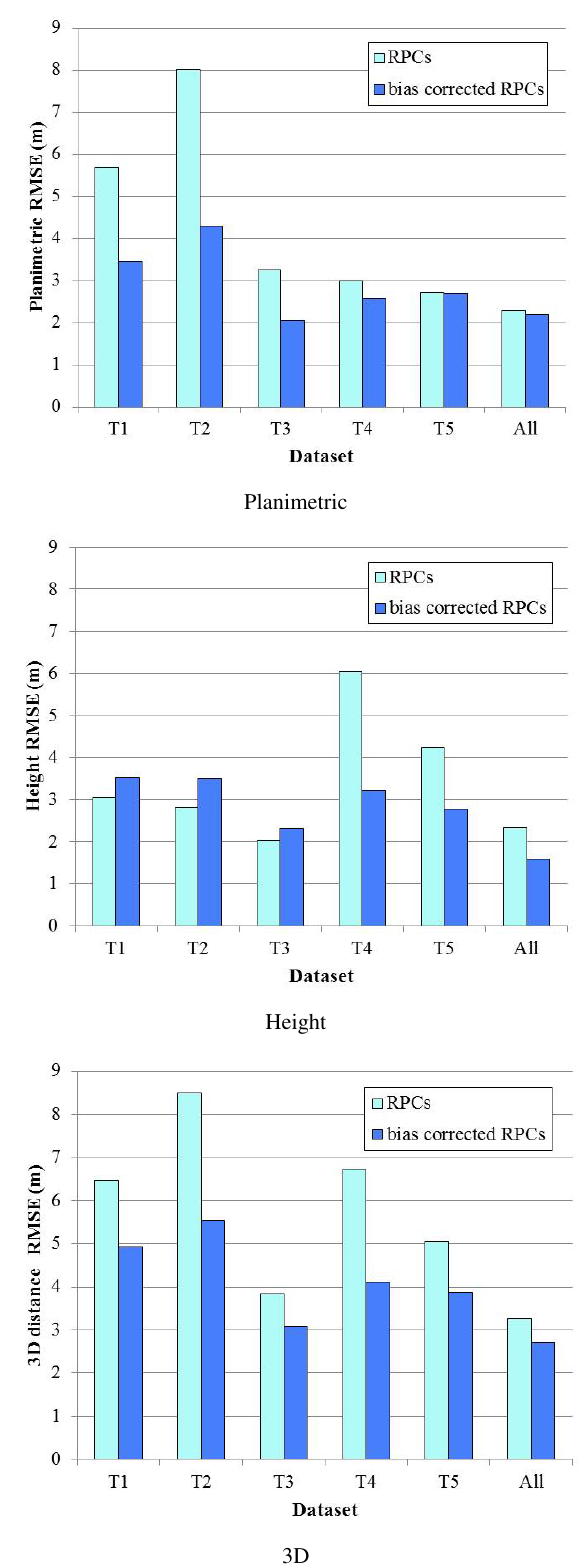
Figure 3. RMSE of coordinates estimated by using the standard RPC model and the bias-corrected RPC